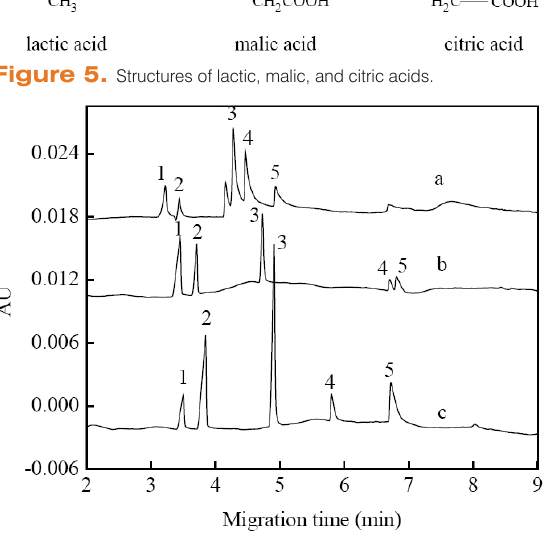
Figure 6. Effects of three organic acids on cation